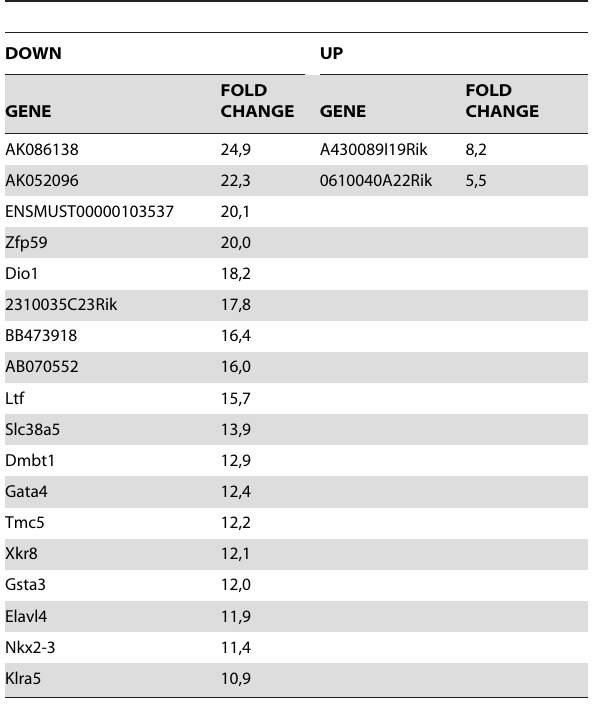
Table 1. Up or down regulated genes in salivary glands of CD40:Fc treated mice versus control mice.